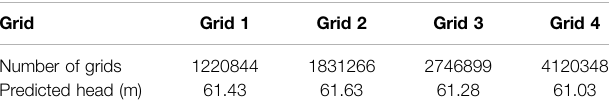
TABLE 2 | Grid independence check for the